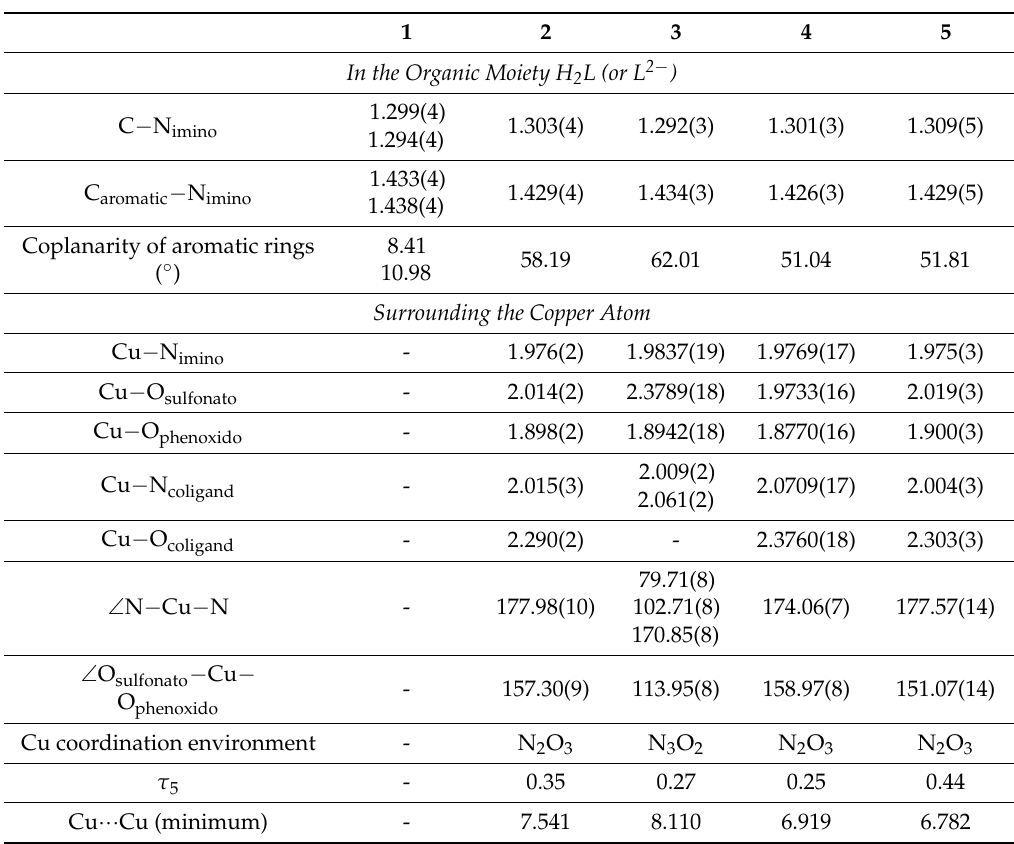
Figure 1. Ball and stick presentation of the crystal structure of 1 . All H-atoms except those participating in H-bonding are omitted for clarity. Symmetry: − x, 1 − y, − z. Table 1. Comparison of some selected features of Schiff base 1 and complexes 2 – 5 . Distances in (Å) and angles in (°).